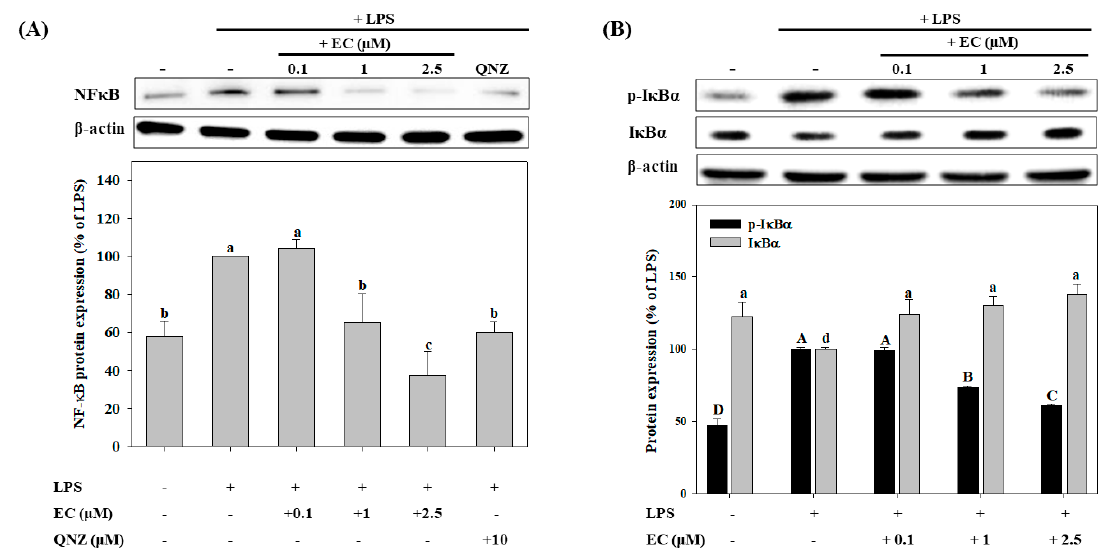
Figure 5. Effects of erinacine C (EC) on LPS-induced NF κ B ( A ), p-I κ B α , and I κ B α ( B ) protein expression in BV2 microglial cells. Cells were pretreated with different concentrations (0.1–2.5 µM) of EC for 1 h, after which the cells were treated with LPS (500 ng/mL) for 24 h. NF κ B, p-I κ B α , and I κ B α protein expressions were determined by western blot analyses. Values (means ± SD, n = 3) not sharing a common capital (or a lower case letter) are significantly different ( p < 0.05). The western blot image is provided as a representative result of multiple experiments.